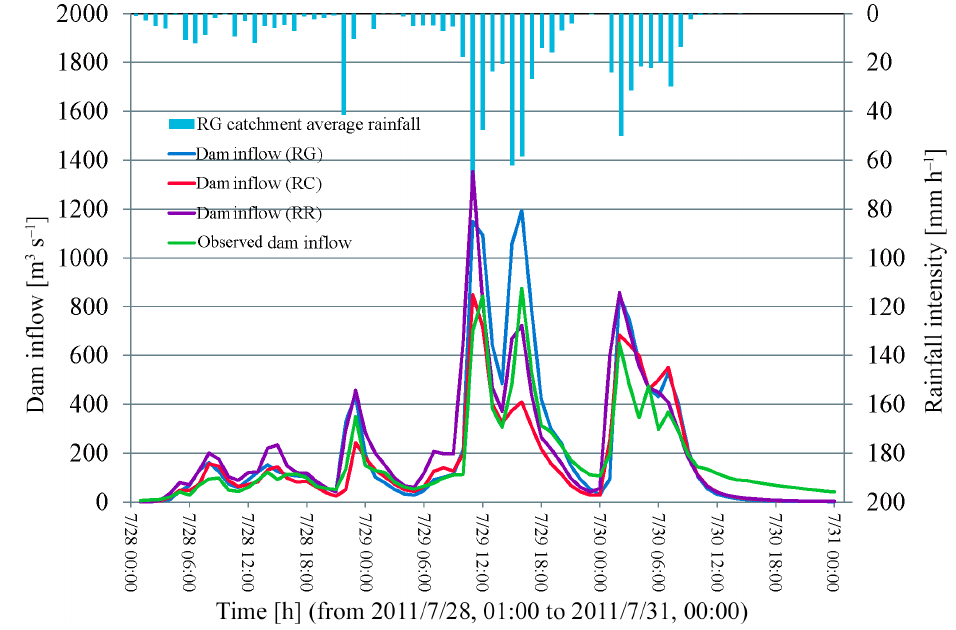
Figure 10. Dam inflows for three rainfalls using the parameters identified with radar